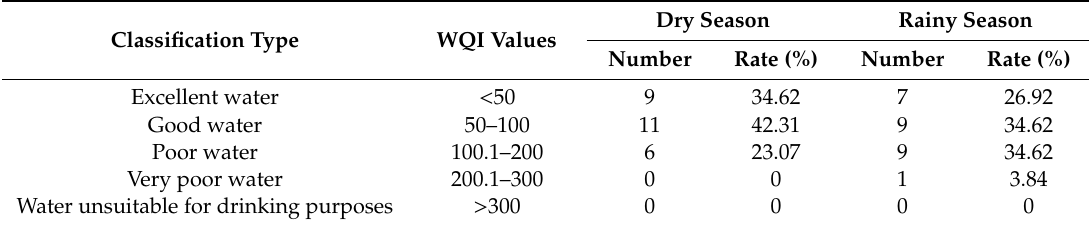
Table 2. Water quality index (WQI) classification for dry and wet season in the Beichuan River. Classification